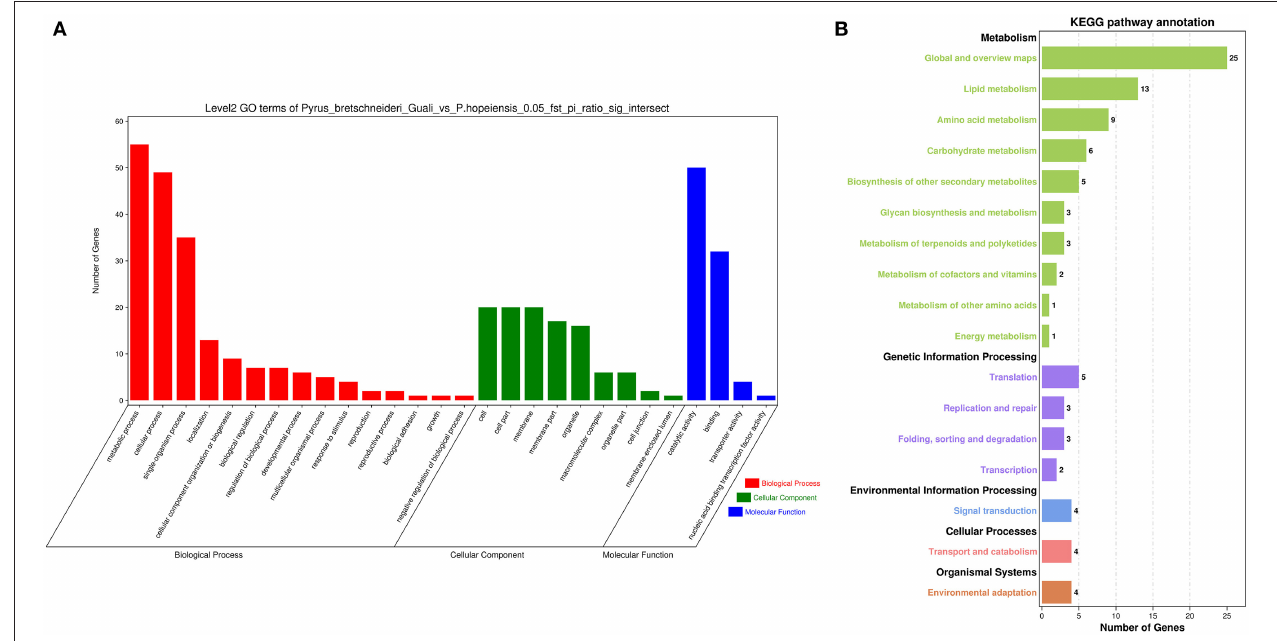
FIGURE 9 | Statistical analysis of enrichment in P. hopeiensis . (A) GO analysis and (B) KEGG pathway analysis.